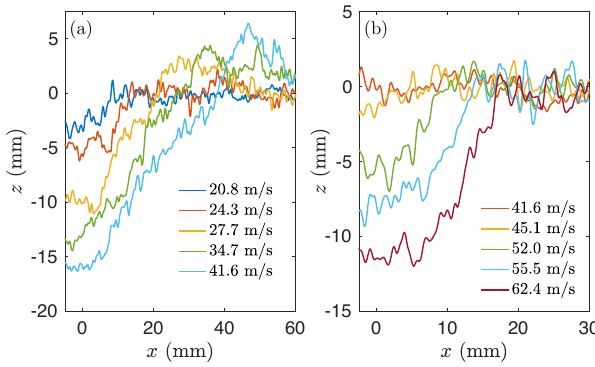
Figure 5. Morphology of the crater when increasing the velocity at the outlet of the nozzle U J for (a) cohesionless grains and (b) cohesive grains (Co =